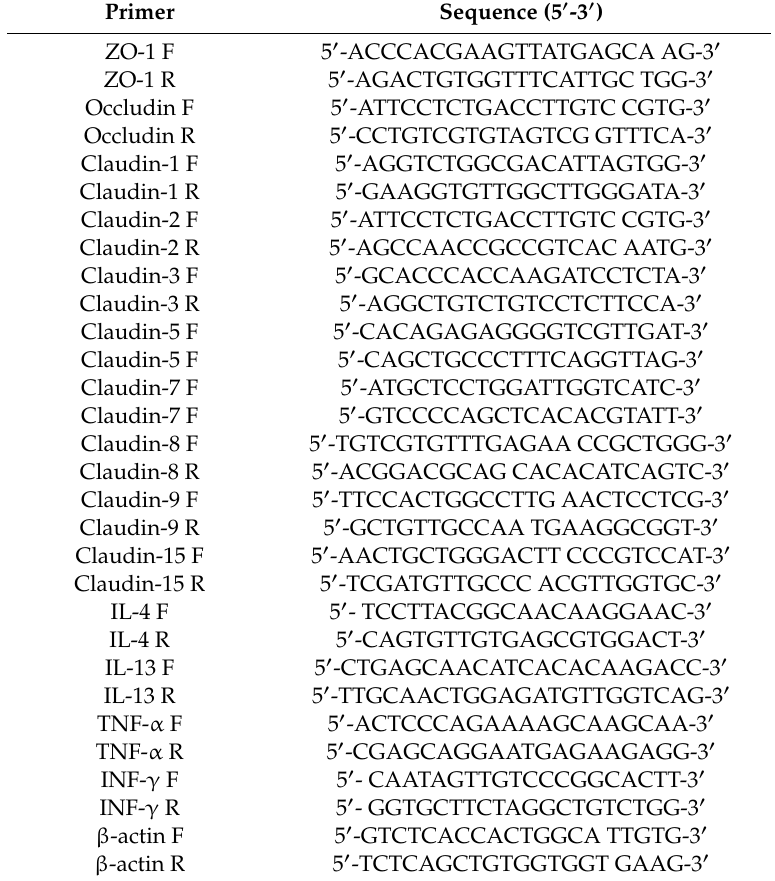
Table 1. Primers used in real time-PCR analysis. ZO, zonula occludens. Primer Sequence (5 (cid:48) -3 (cid:48) ) ZO-1